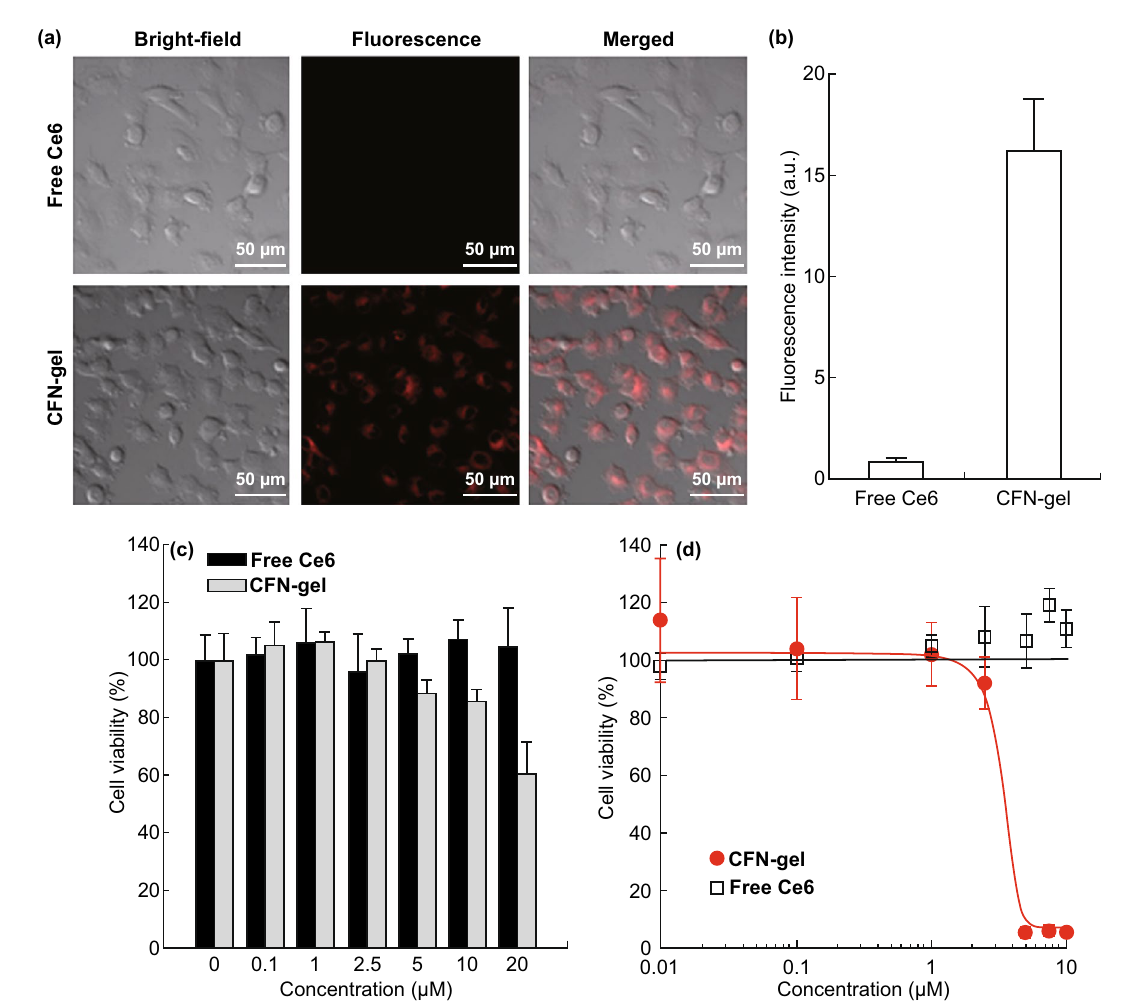
Fig. 5 a NIR fluorescence images of free Ce6 and CFN‑gel‑treated HT1080 cancer cells. The HT1080 cancer cells were treated with free Ce6 or CFN‑gel at a 2 µM Ce6 equivalent for 6 h. After washing the cells, NIR fluorescence images ( λ ex = 633 nm, λ em = 650, using a long‑pass filter) were obtained. The red color indicates the fluorescence signals generated from Ce6, b quantitative analysis of fluorescence intensities in the free Ce6 and CFN‑gel‑treated HT1080 cells ( n = 4), c in vitro dark cytotoxicity of the HT1080 cells after treatment with free Ce6 and CFN‑gel at various concentrations, d in vitro phototoxicity of the HT1080 cells after treatment with free Ce6 and CFN‑gel at various concentrations upon 670‑nm light irradiation (50 mW cm −2 , 10 J cm −2 ). The IC 50 of the CFN‑gel is 2.73 µM. (Color figure